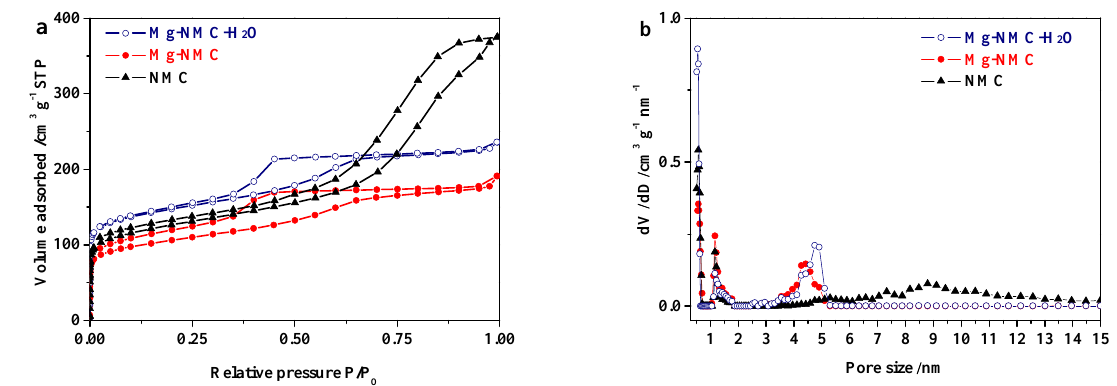
Figure 5. N 2 sorption isotherms ( a ) and pore size distribution plots ( b ) of NMC (solid triangles), Mg-NMC (solid circles) and Mg-NMC-H 2 O (open circles).